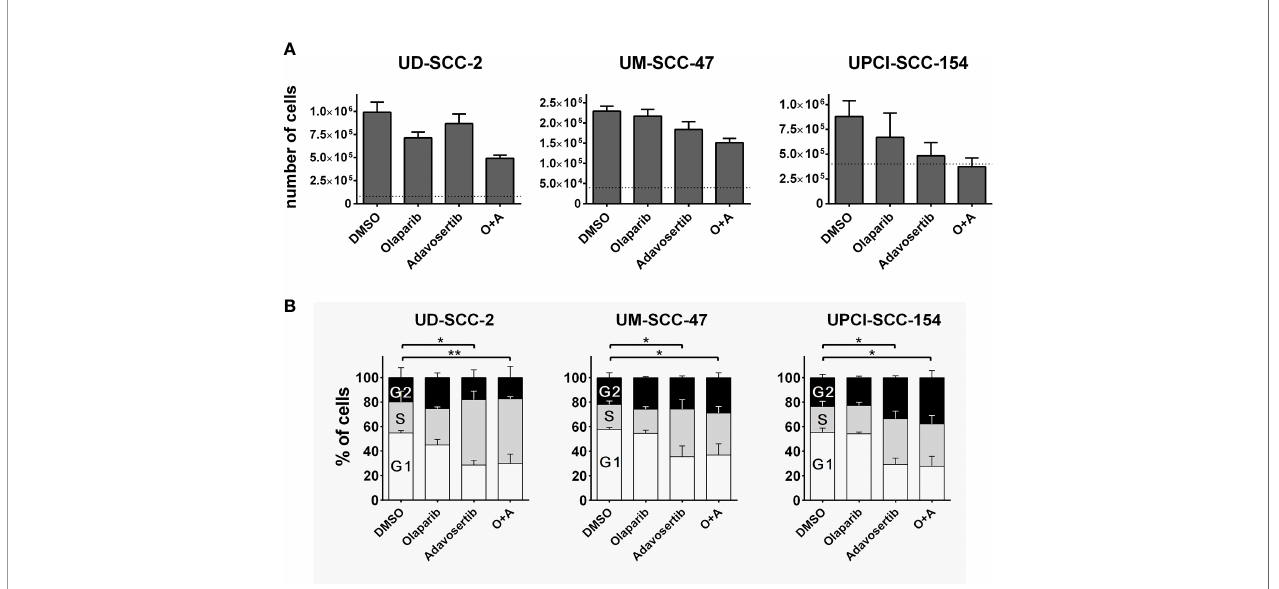
FIGURE 1 | Interactions of PARP and Wee1 inhibition. (A) Proliferation. Cells were seeded and after 4 h treatment with inhibitors as indicated. Five days later the respective numbers of cells were assessed. Dotted lines indicate the number of cells seeded. Adavosertib: UD-SCC-2 & UM-SCC-47, 120 nM; UPCI-SCC-154, 60 nM. Olaparib: all strains 500 nM. (B) Cell cycle. Cells were seeded and on the next day treated with the respective inhibitors. After 24 h, the cells were fi xed and subjected to DAPI staining and fl ow cytometric assessment of cell cycle distribution. Adavosertib: UD-SCC-2 & UPCI-SCC-154, 480 nM; UM-SCC-47, 960 nM. Olaparib: all strains 1 µM. Statistical evaluation was performed for changes in the S-phase population; addition of olaparib did not induce any signi fi cant changes. Asterisks depict signi fi cant differences with * and ** indicating p < 0.05 and p < 0.01, respectively (two-tailed Student ’ s